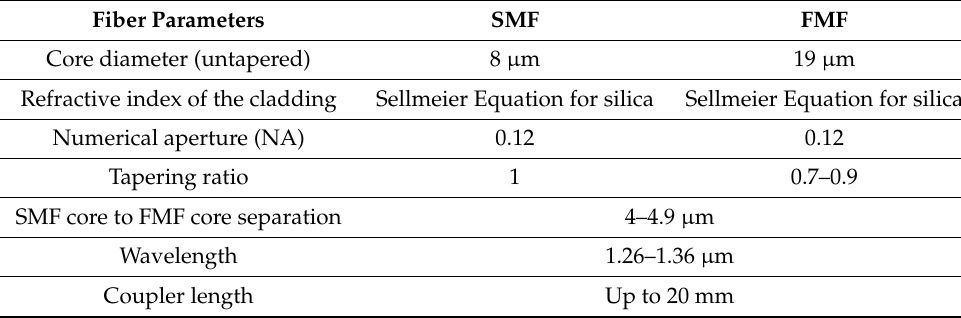
Table 1. Simulation parameters in the side coupling.